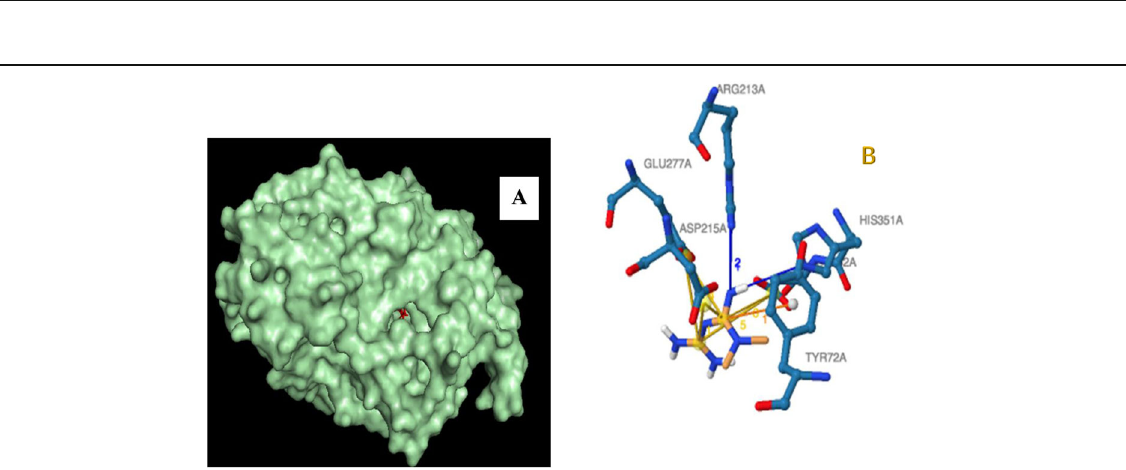
Fig. 7 Binding pose and binding site of metformin with α -glucosidase (panel A), molecular interaction of metformin with amino acid residues within the binding pocket of the protein structure (panel